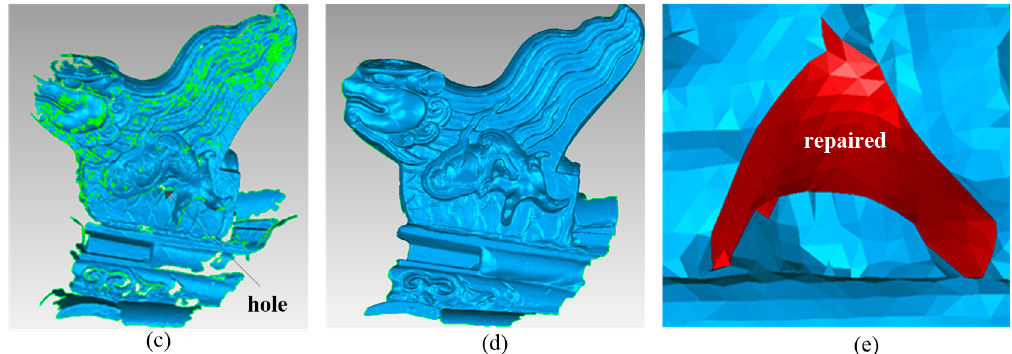
Figure 9. Noise filtering and data repair of the component point cloud: ( a ) original point cloud; ( b ) hole in detail; ( c ) result of noise filtering; ( d ) result after filtering and repairing; ( e ) result of data repair.